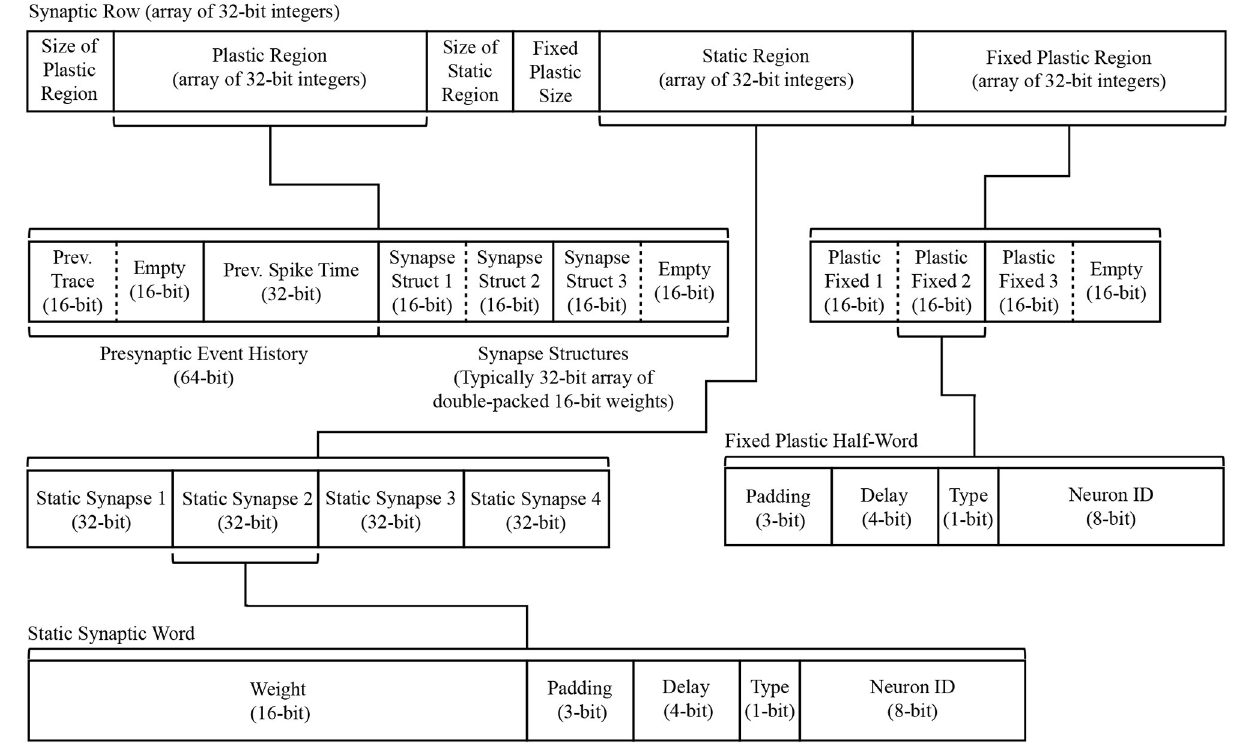
Frontiers in Neuroscience |